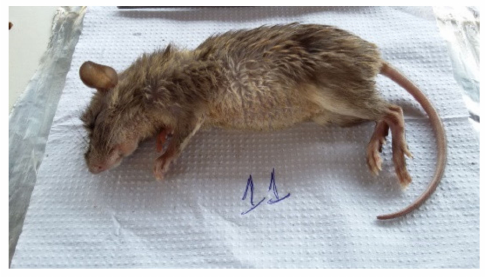
Figure 4. Proechimys roberti.